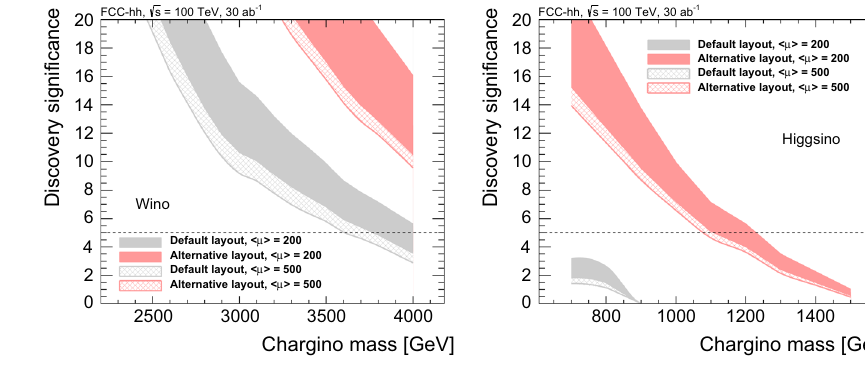
Fig. 12.2 Expected discovery significance at 30 ab − 1 with 500 pile-up collisions. The black (red) band shows the significance using the default and alternative tracker layouts described in the text and in Refs. [341,342]. The band width represents the difference between the two models of